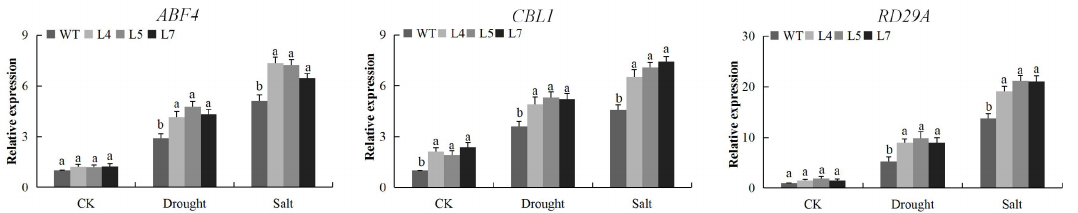
Figure 11. Expression levels of abiotic stress-responsive genes ( ABF4 , CBL1 and RD29B ) in transgenic Arabidopsis lines (L4, L5 and L7) and wild type Arabidopsis Atactin2 gene was used as the reference, each experiment was repeated three times, mean values with ± SD, (a,b) calculated by Student’s t -test with p <